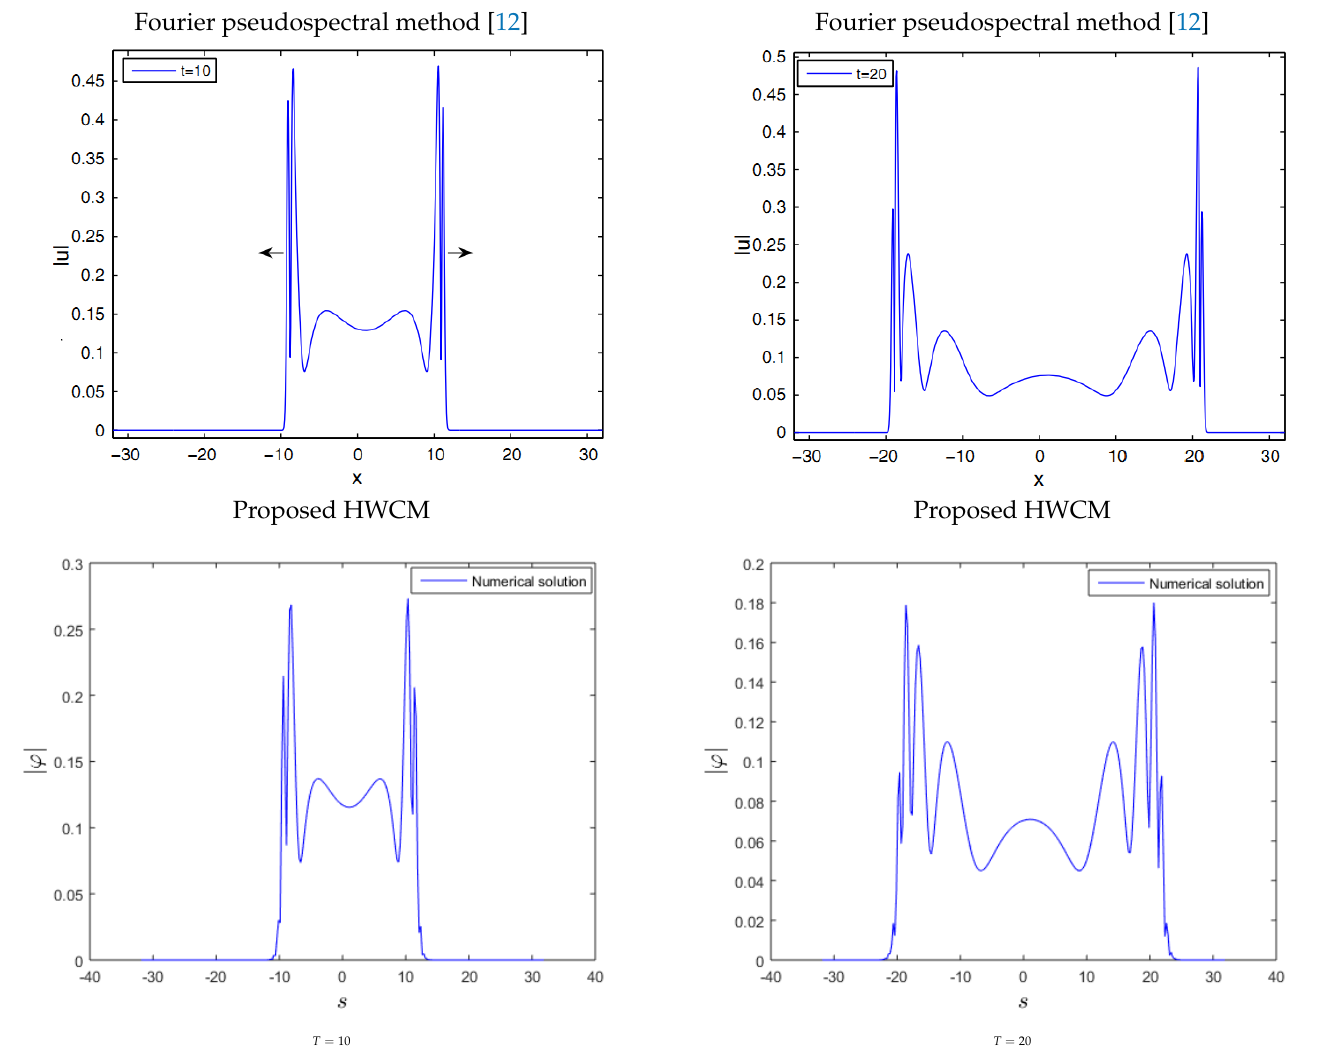
Figure 4. Comparison of propagating soliton obtained form different methods for Test Problem